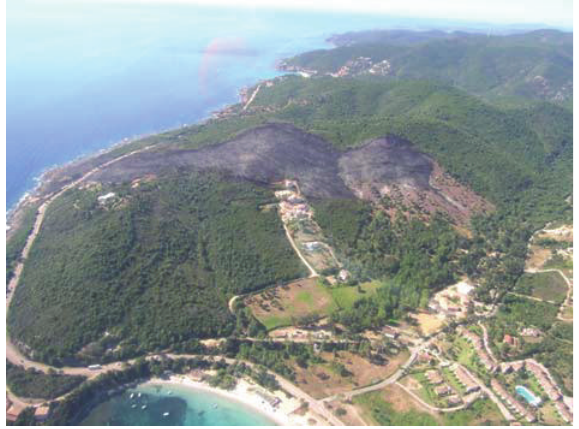
Figure 3: Fire perimeter for the case study of Favone fire (courtesy of South-Corsica